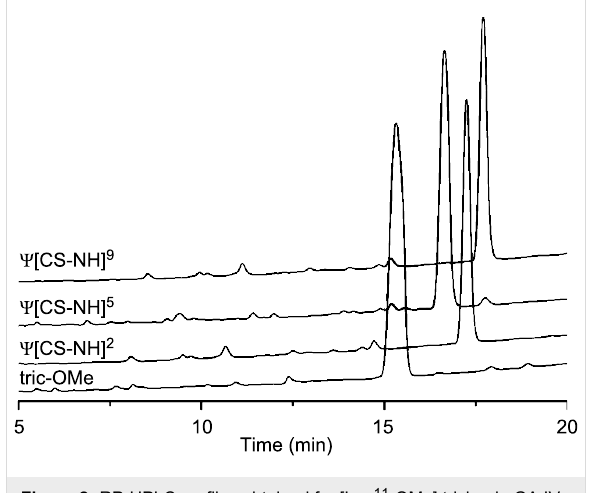
Figure 2: RP-HPLC profiles obtained for [Leu 11 -OMe] trichogin GA IV ( tric-OMe ) and its ψ [CS-NH] 2 , ψ [CS-NH] 5 , and ψ [CS-NH] 9